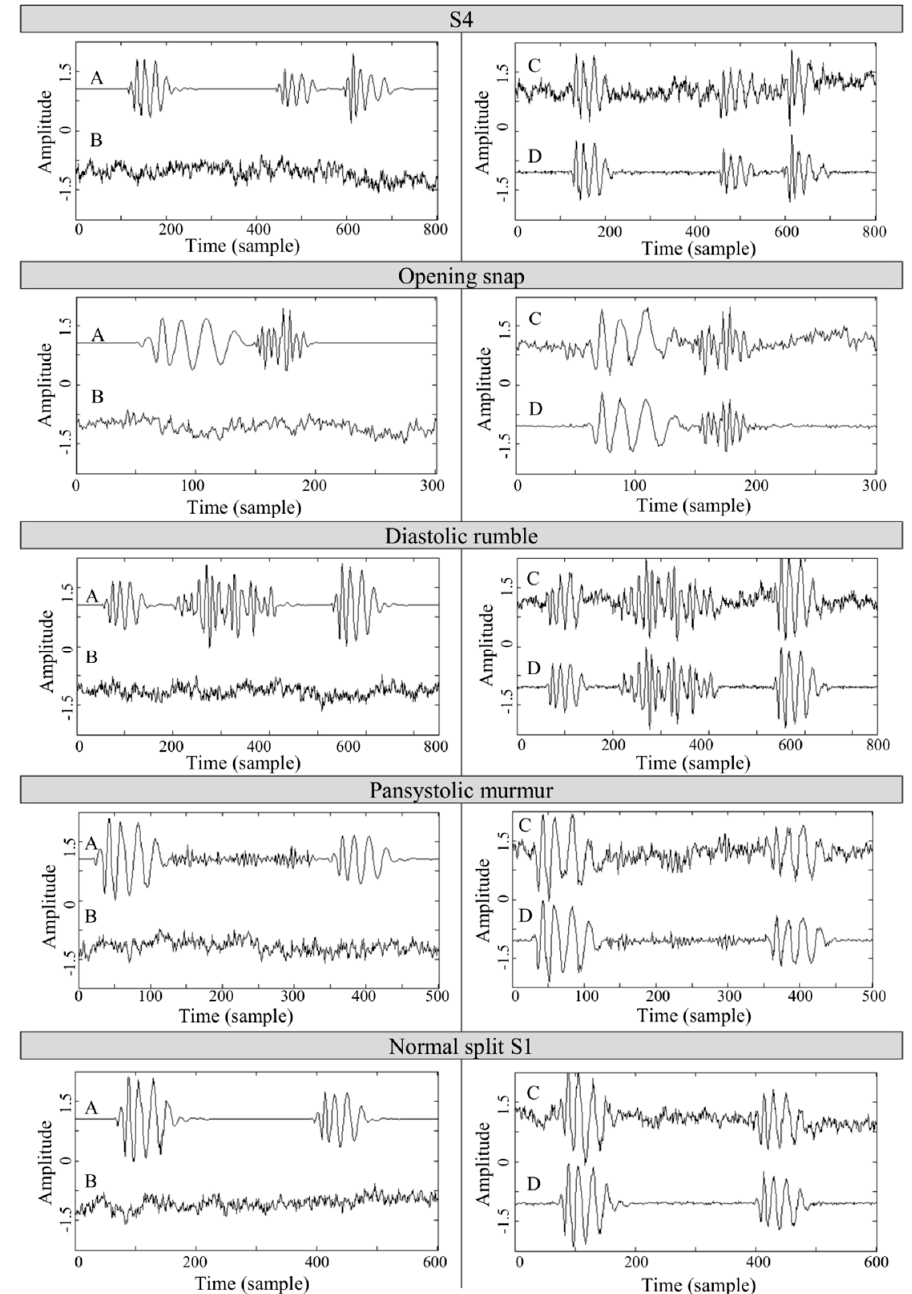
Figure A1. The final results of the filtration process. A—desired signal, B—the pink noise of SNR = 10 dBm, C—noised signal, and D—denoised signal.